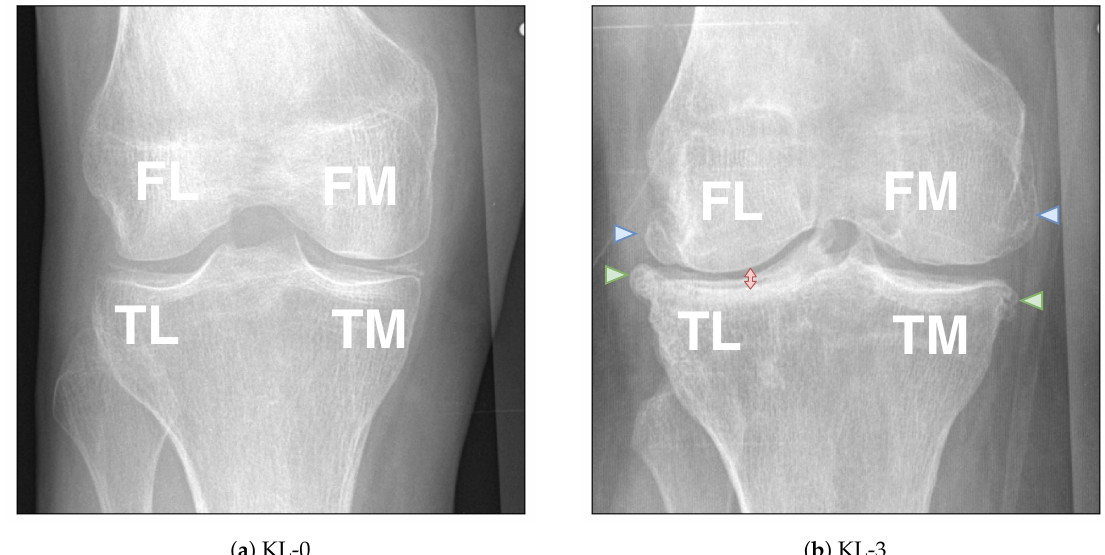
Figure 1. Examples of knee osteoarthritis features graded according to the Osteoarthritis Research Society (OARSI) grading atlas and Kellgren–Lawrence (KL) grading scale. FL, TL, FM and TM represent the femoral lateral, tibial lateral, femoral medial and tibial medial compartments, respectively. I ( a ) A right knee without visual OA-related changes is presented (KL 0, all OARSI grades also zero). ( b ) An image of a right knee with severe OA (KL 3) is presented. Blue triangles highlight the osteophytes in femur and the green triangles highlight the osteophytes in tibia. Red arrow highlights the joint-space narrowing (JSN). Here, the osteophytes for FL, TL, FM and TM compartments are all of Grade 3. JSN in the lateral compartment is of Grade 2 and in the medial compartment it is of Grade